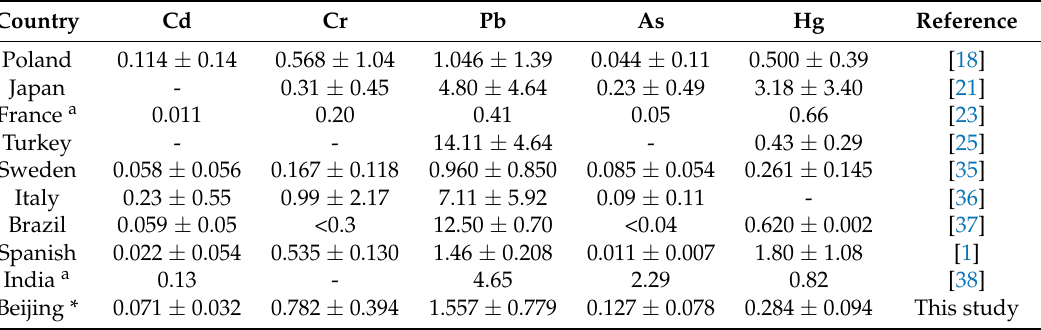
Table 2. Comparison of hair metal levels in different countries (Mean ± S.D.